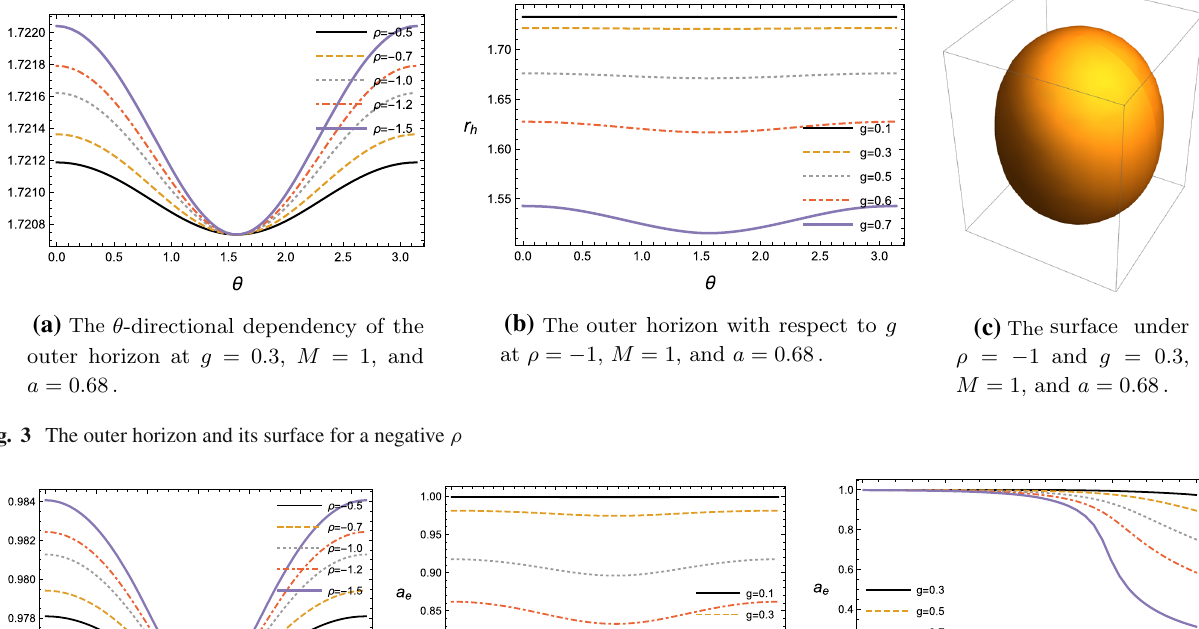
extremal spin parameter with respect to θ at ρ = − 1 and M = 1.